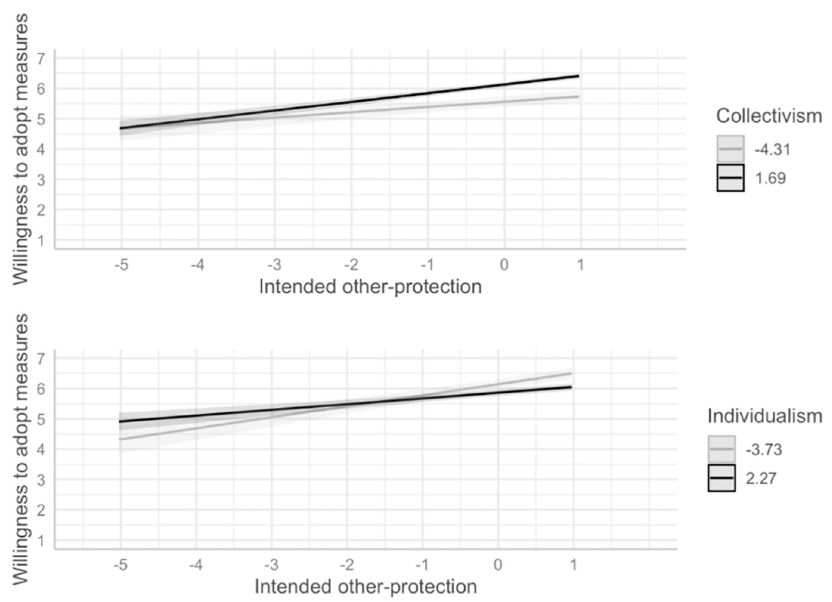
Fig 1. Collectivism–pro-sociality hypothesis. The figure displays predicted values and not the observed data. Lighter (vs. darker) shading for collectivism and individualism represents minimum and maximum values of the variables after mean-centering. Collectivism and individualism moderate the effect of pro-social motivation on the willingness to adopt protective measures. Independent variables were mean-centered. Darker (lighter) lines, shades, and the values in the legend indicate higher (lower) levels of the